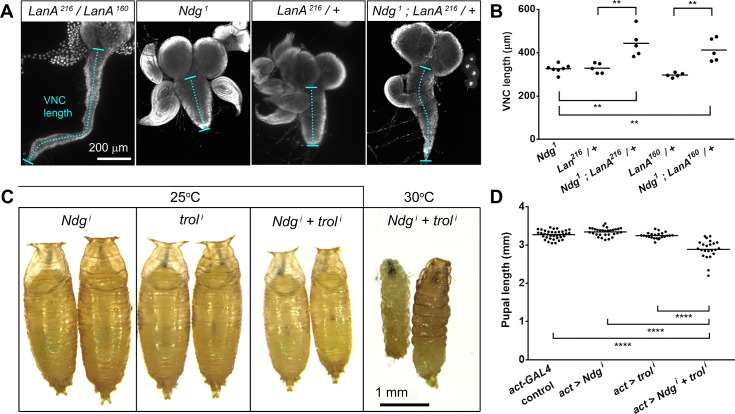
Ndg loss enhances Laminin and Perlecan loss phenotypes.(A) Larval ventral nerve cord (VNC) in LanA216/LanA160, Ndg1/Ndg1, LanA216/+ and Ndg1/Ndg1; LanA216/+ larvae. (B) Quantification of VNC length in Ndg1, LanA216/+, Ndg1; LanA216/+, LanA160/+ and Ndg1; LanA160/+. Each dot represents an individual VNC measurement. Horizontal lines indicate the mean value. Differences with the control were significant in non-parametric Mann-Whitney tests (**; p<0.01). (C) Images of pupae where Ndg, trol or both Ndg and trol have been knocked down using act-GAL4 at either 25°C or 30°C. (D) Quantification of pupal length in wild type control, act>Ndgi, act>troli and act>Ndgi+troli pupae. Each dot represents a single pupa measurement. Horizontal lines indicate the mean value. Differences with the control were significant in non-parametric Mann-Whitney tests (****; p<0.0001).